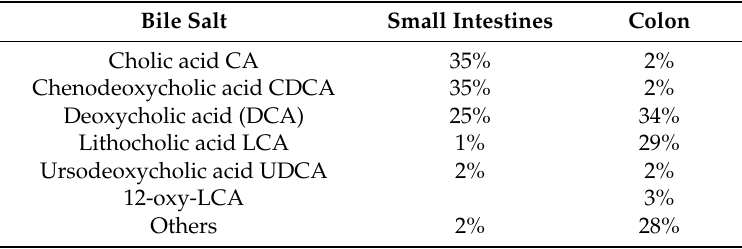
Table 1. Bile salt composition in the small intestines and colon. Data are from Ridlon et al. [52]. Bile Salt Small Intestines Colon Cholic acid CA 35%